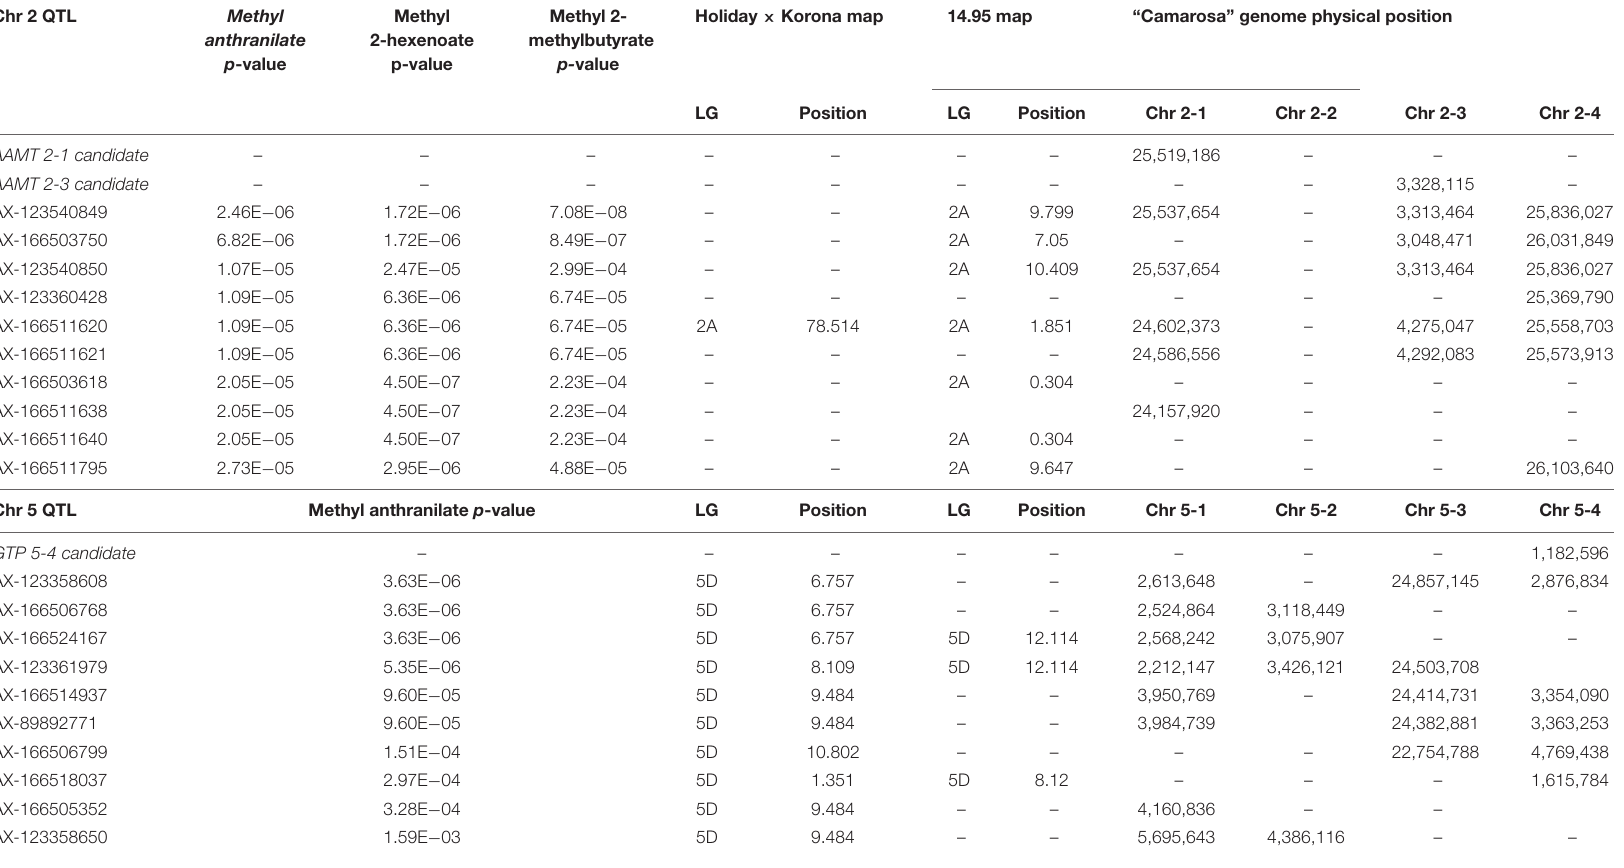
TABLE 1 | Methyl anthranilate QTL and candidate gene